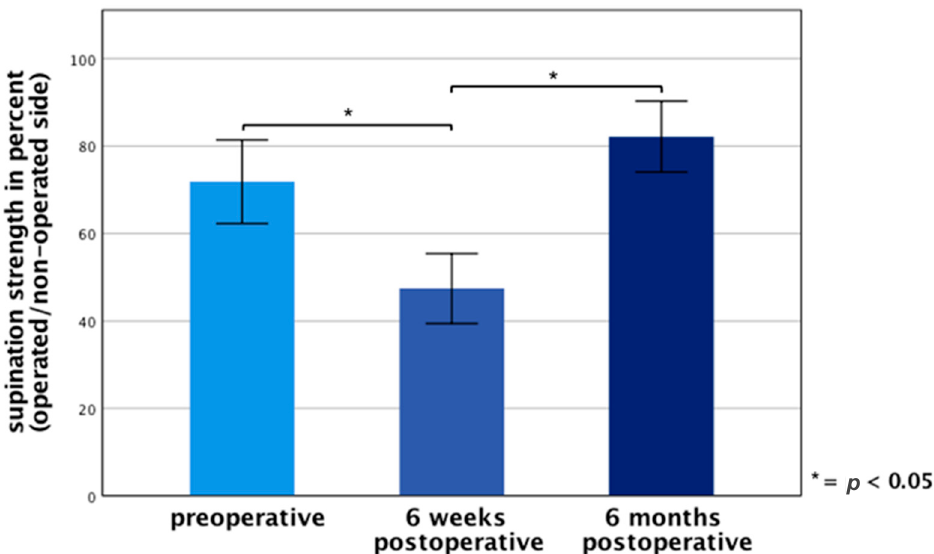
Figure 4. Side-by-side comparison of supination strength in percent. Error bars indicate 95% CI. Significant differences (* p < 0.05) are designated by asterisks.